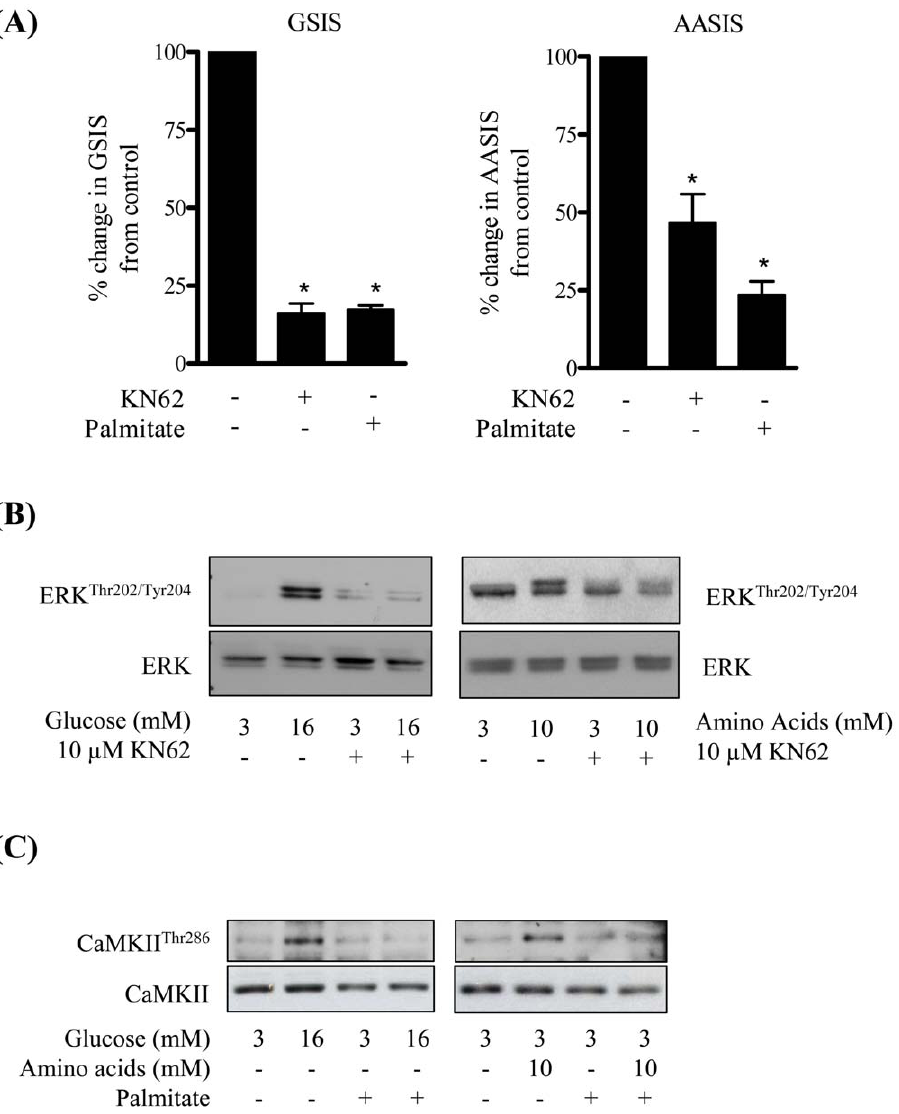
Figure 6. Palmitate antagonises the stimulus-induced activation of ERK and CaMKII in MIN6 b cells. MIN6 b cells were incubated with 10 m M KN62 (an inhibitor of CaMKII) for 2 h. In the last hour of this incubation cells were incubated with either glucose (16 mM) or amino acids (10 mM) prior to assessing (A) GSIS or AASIS, (B) ERK activation by analysis of ERK Thr202/Tyr204 phosphorylation. Total ERK content was used for assaying protein loading. Alternatively, MIN6 b cells were incubated in the absence or presence of palmitate (0.4 mM) for 48 h and then stimulated insulin secretion assessed by the addition of glucose or amino acids for 1 h at the concentrations indicated. Cells were lysed and lysates immunoblotted to assay phospho-CaMKII Thr286 phosphorylation with native CaMKII serving as a gel loading control (C). Bars represent mean 6 SEM from 3 separate experiments and asterisks signify a significant difference from the untreated control values (P , 0.05).